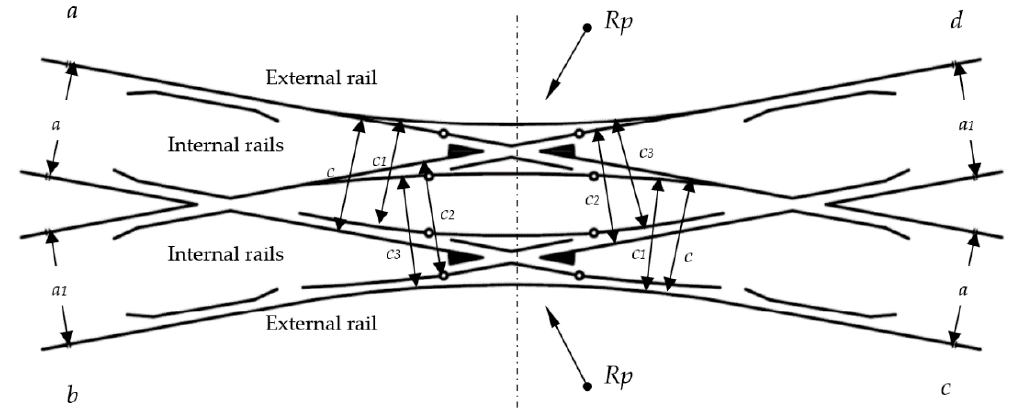
Figure 10. Measurement of the track gauge and cant parameter at the point cross-sections.